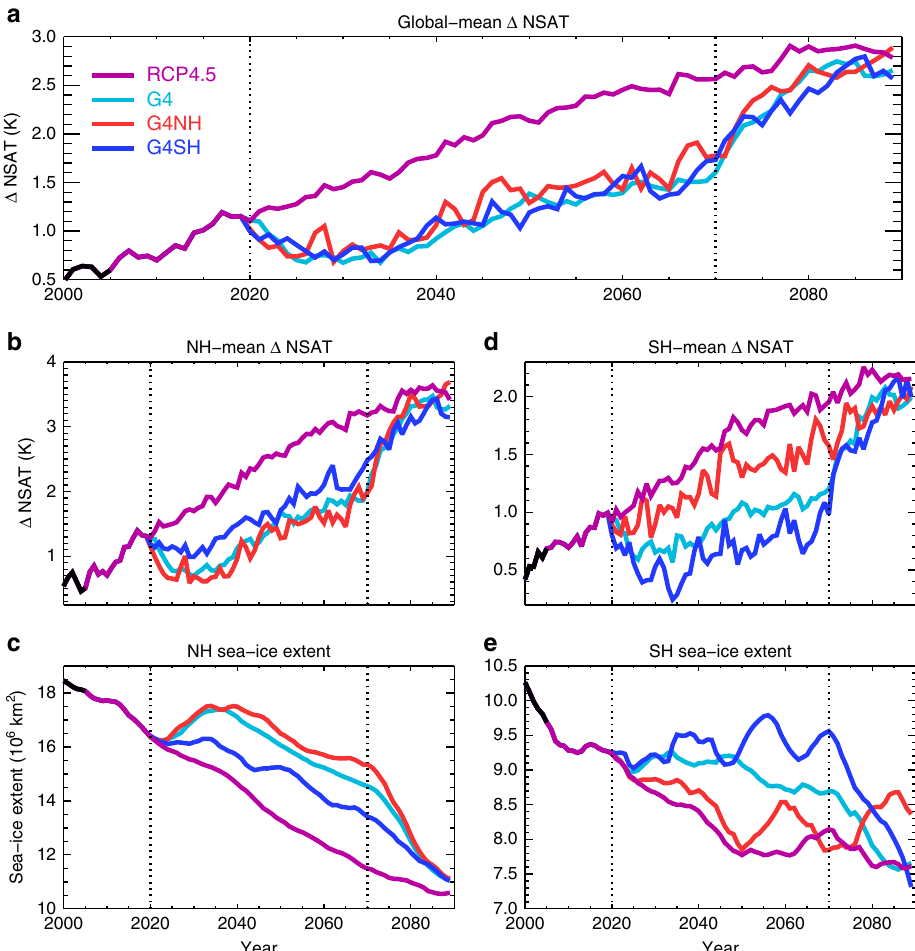
Fig. 3 Twenty- fi rst century temperature and sea-ice changes. a Global-mean near-surface air temperature (NSAT) anomaly relative to a 240-year pre-industrial control simulation for RCP4.5, global solar geoengineering (G4), northern hemisphere (NH) solar geoengineering (G4NH),and southern hemisphere (SH) solar geoengineering G4SH; b , c , NH NSAT anomaly and total sea-ice extent (10 6 km2); d , e , SH NSAT anomaly and total sea-ice extent. Sea-ice extents are smoothed by a 10-year simple moving average. Vertical dotted lines at years 2020 and 2070 indicate the start and cessation of solar geoengineering, respectively